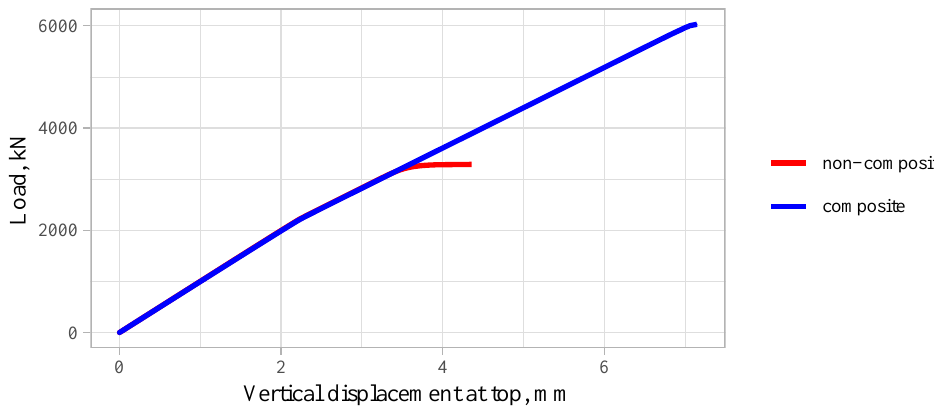
Figure 16. Load–displacement behaviour of the inner wall until